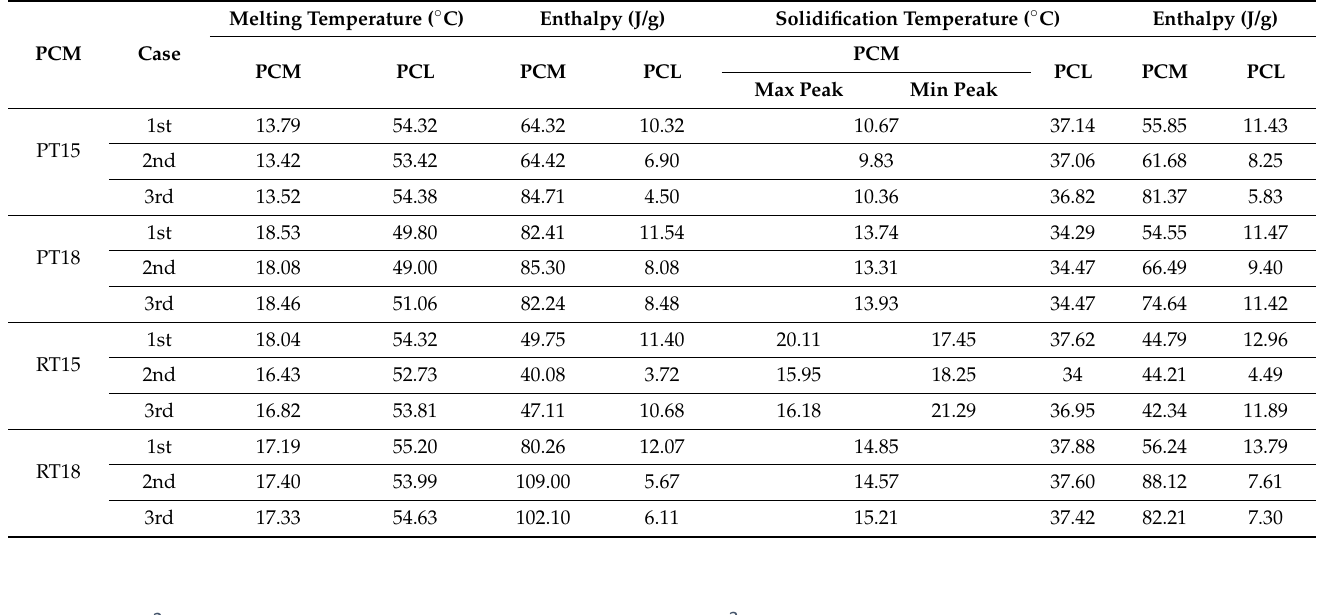
Table 4. DSC results for electrospun PCM fibers of PT15, PT18, RT15, and RT18 in the 1st thermal cycle.